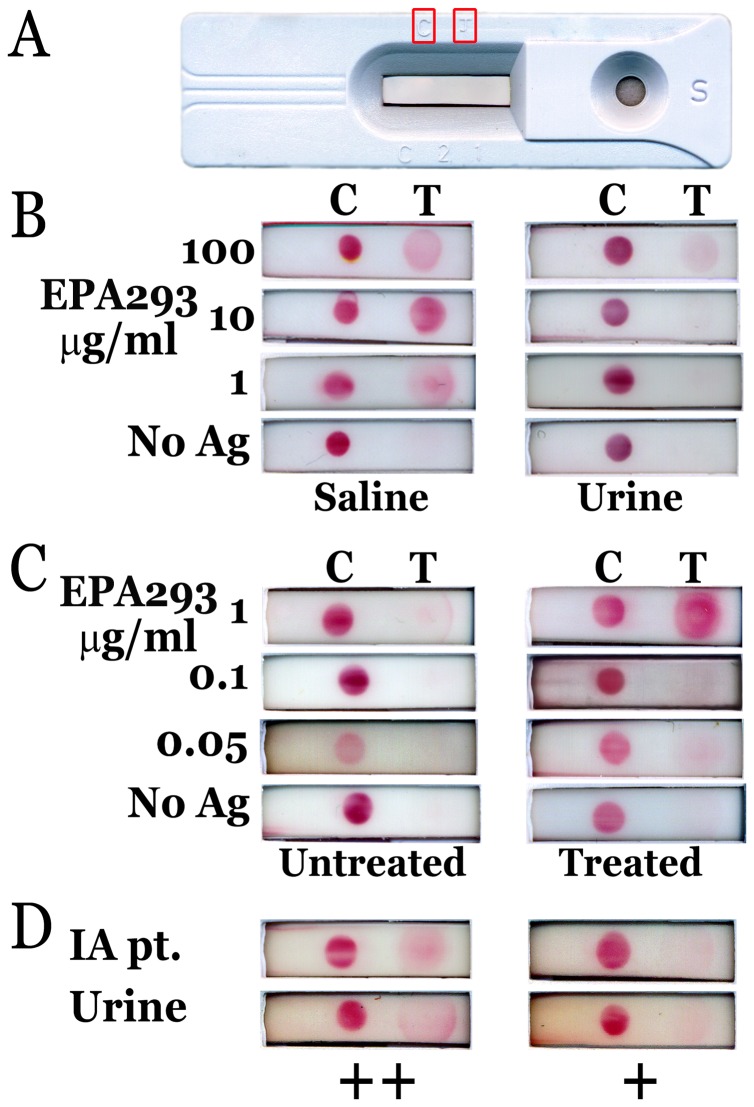
MAb476-based Lateral flow immunochromatographic assay device (LFD) detects Galf antigen in simulated and human urine samples.
A, appearance of the assembled LFD; subsequent panels show scanned images of the reaction window. B, Comparison of urine and normal saline (NS) as diluent for EPA293 in LFD. C, Detection of EPA293 in simulated samples after concentration (5–10 folds, 3 KDa MWCO) and desalting (7 KDa MWCO), compared to no treatment. D, Detection of Galf-containing antigen in processed clinical urine samples; 2 patients have intermediate (++) positive signal and 2 have weak (+) positive signal.